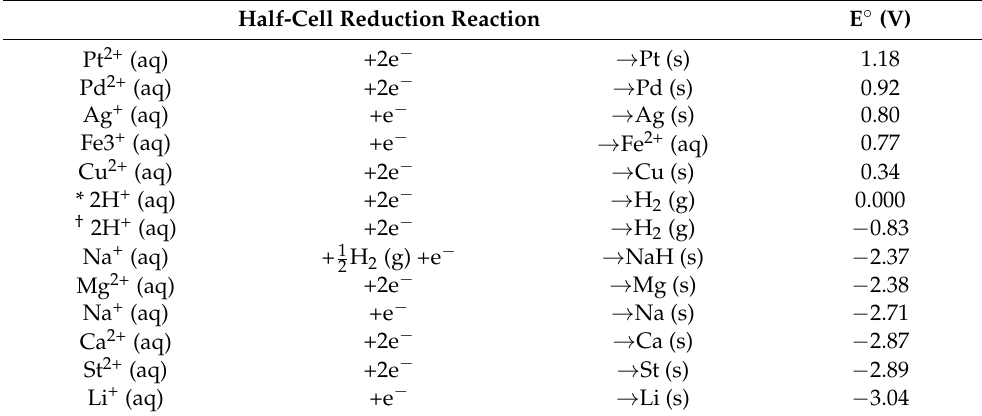
Table 2. Redox potentials for various minerals/metals. Half-Cell Reduction